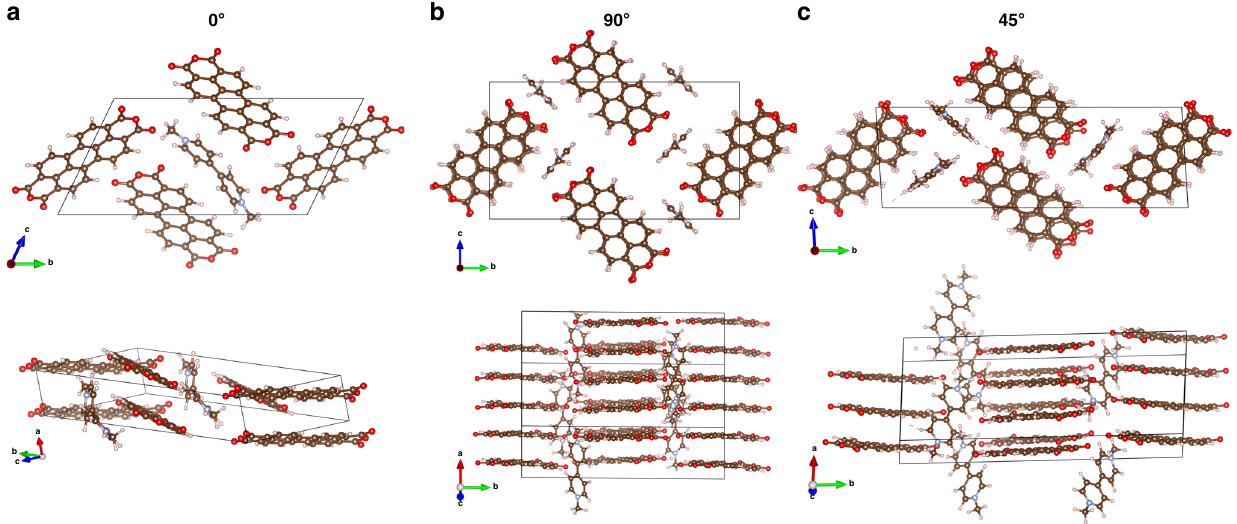
Fig. 6 Models of simulated MV 2 + -inserted PTCDA in vertical geometries from top view (top) and side view (bottom): a 0°; b 90°; c 45°. Angles are indicating relative slope to PTCDA